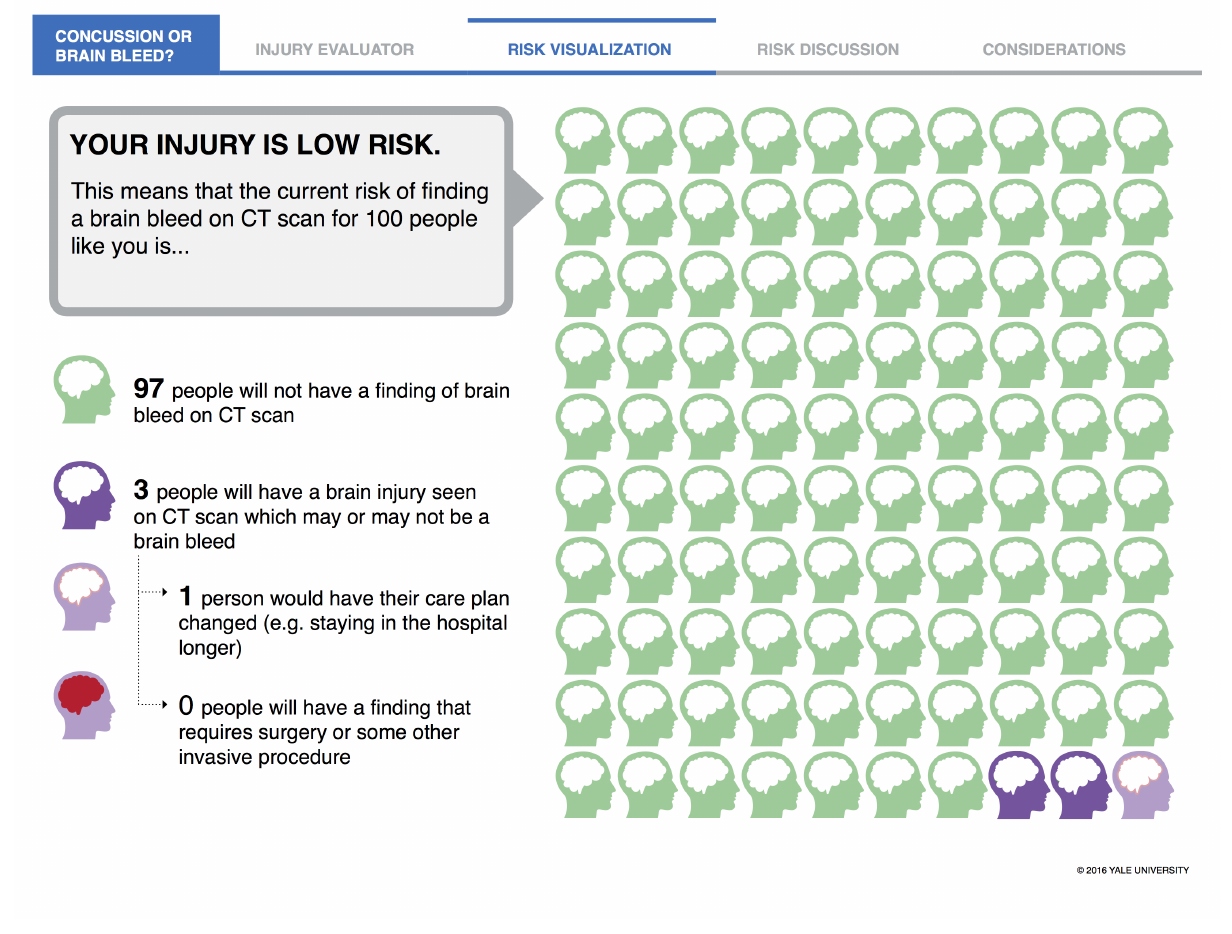
Figure 2. Risk visualization screen shot for low-risk patients from the Concussion or Brain Bleed app. CT: computed